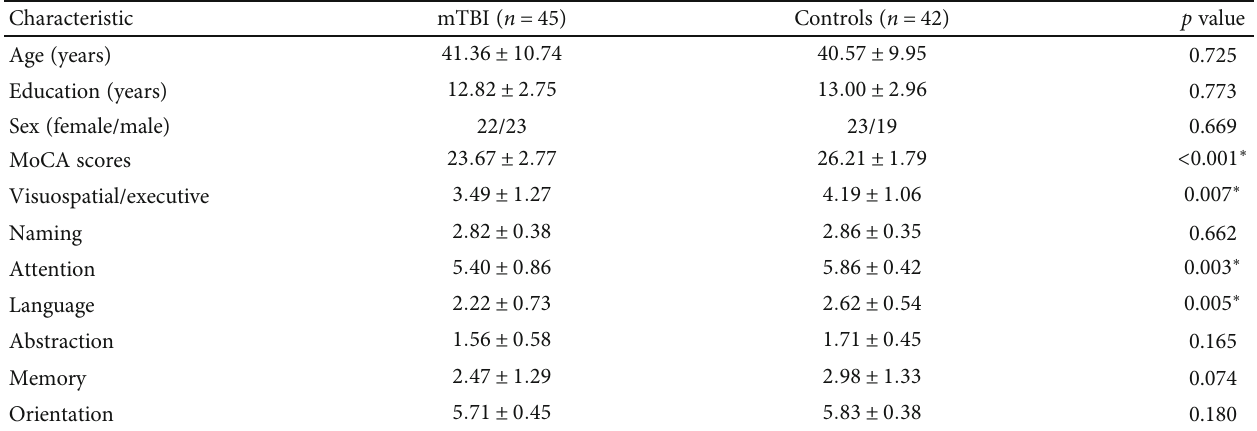
Table 1: Demographic and clinical characteristics of the mTBI patients and healthy